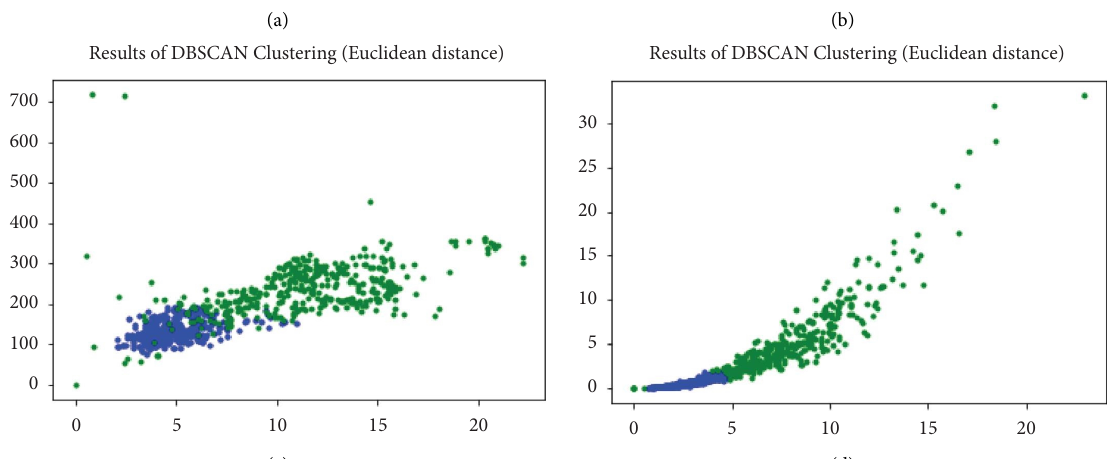
1 , (b) feature vector f 2 , (c) feature vector f 3 , and